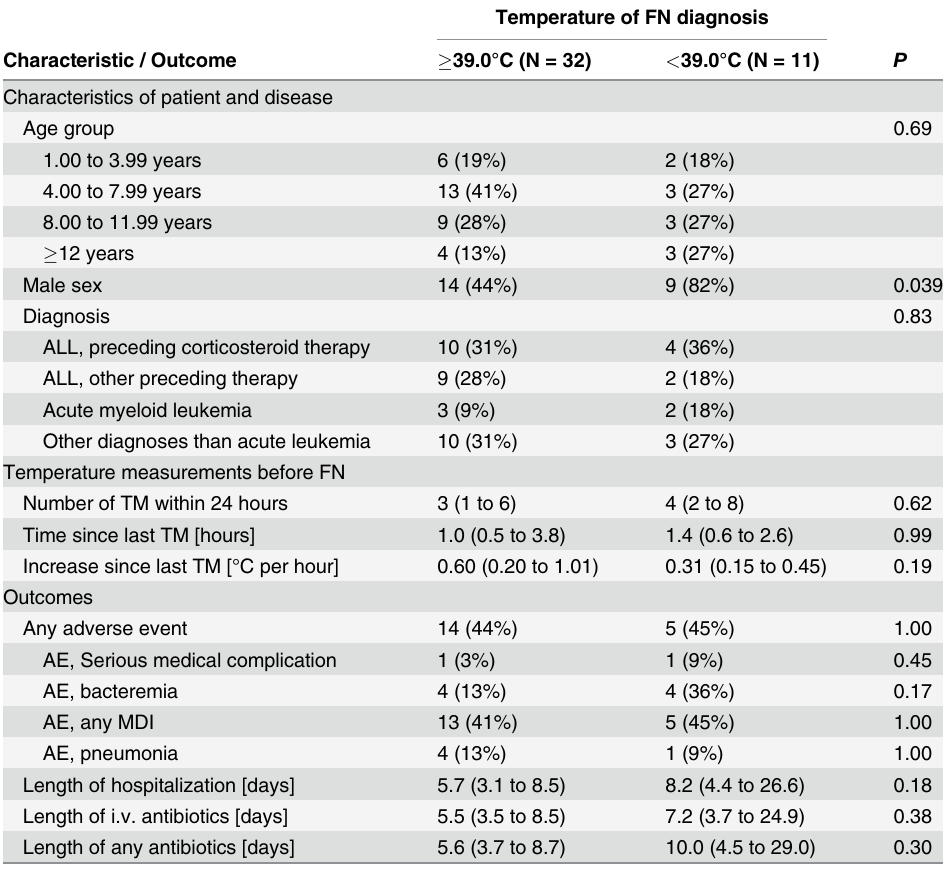
Indicated are numbers (proportion of all episodes) and P -values from Fisher ’ s exact test for